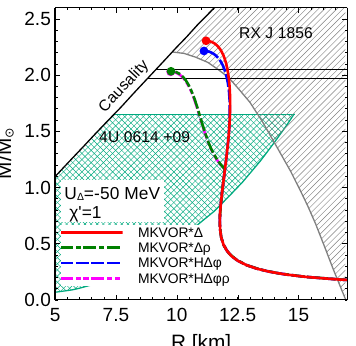
Figure 4. Neutron star masses versus radii for MKVOR* ∆ , MKVOR*H ∆ φ , MKVOR* ∆ ρ , MKVOR*H ∆ φρ